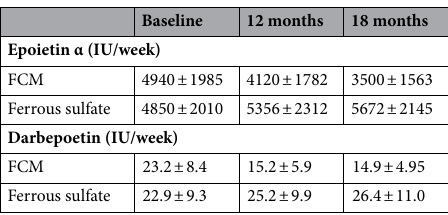
Table 3. Epoietin α and darbepoetin therapy at different time points in the two study groups.